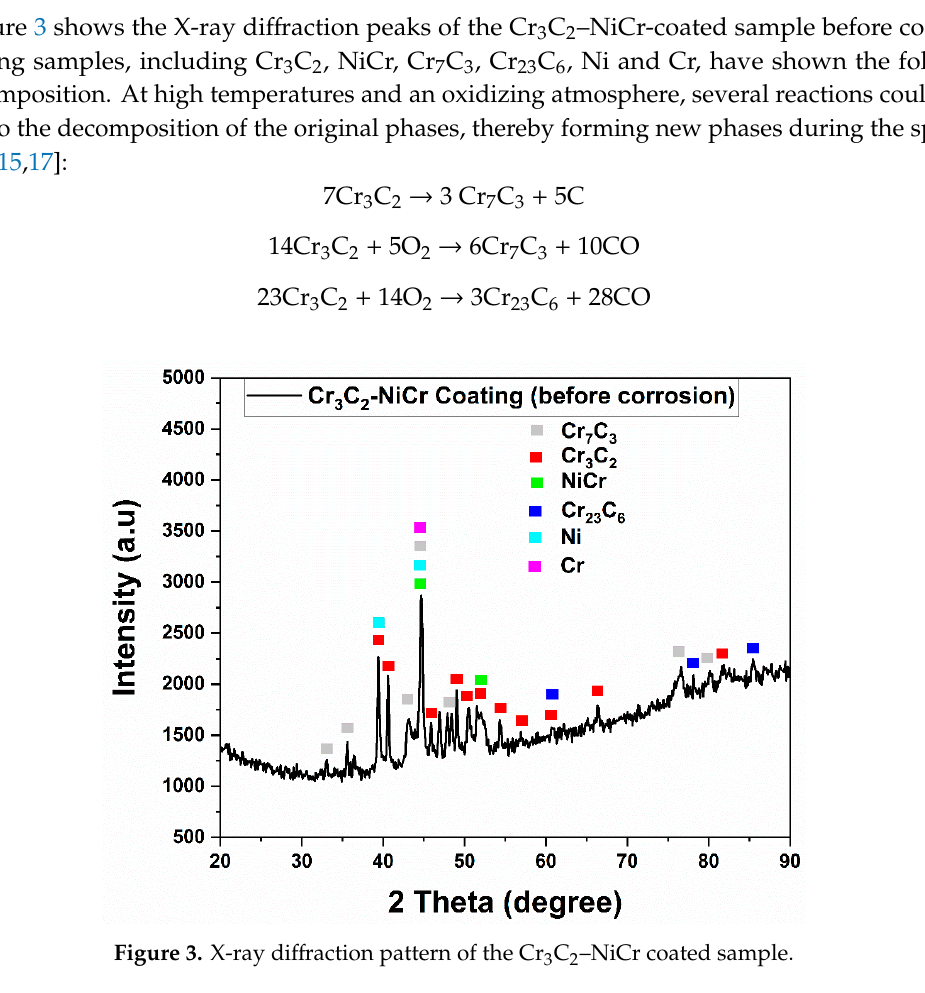
3 C 2 –NiCr coated